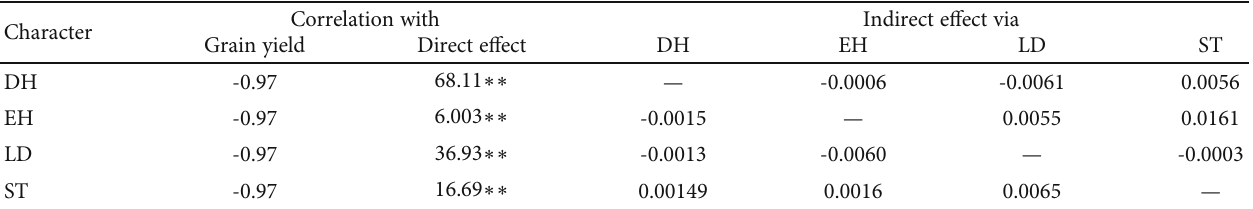
Table 8: Direct and indirect e ff ects of C. partellus damage traits on total grain yield at Kiboko site.